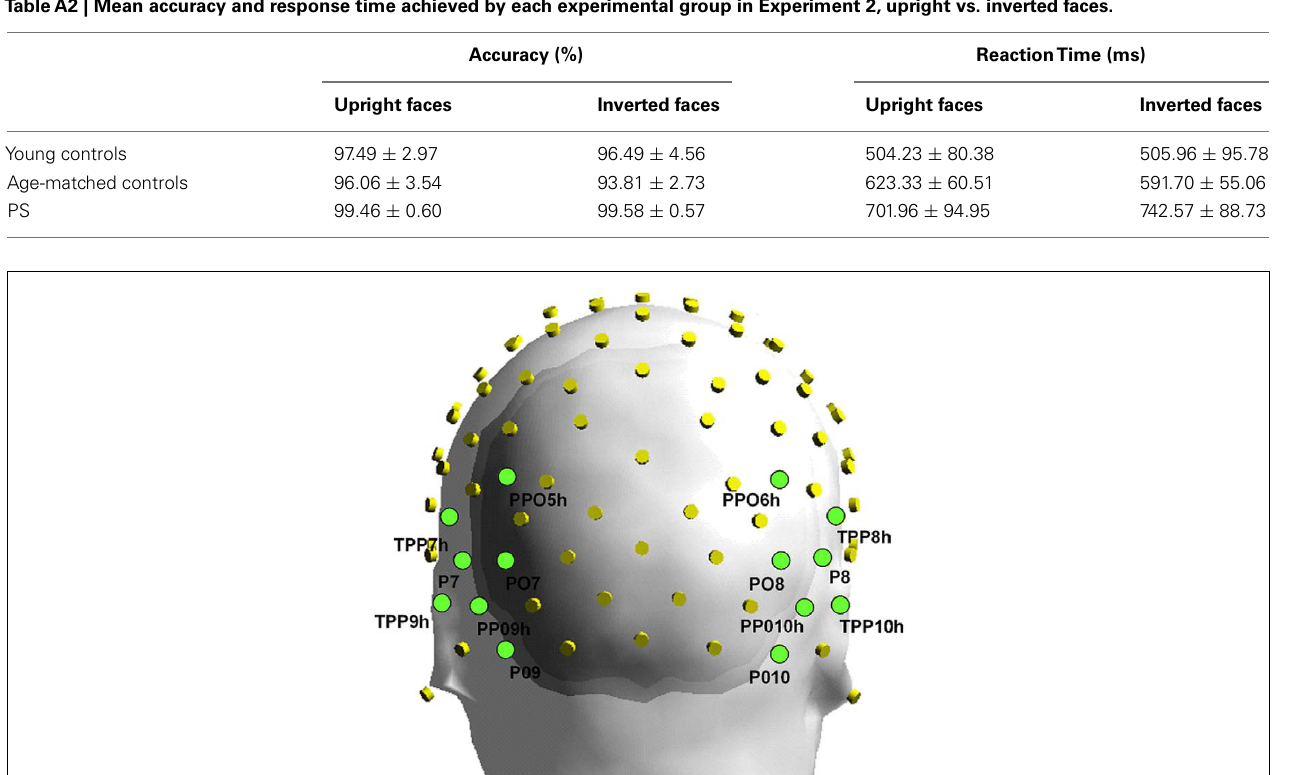
TableA2 | Mean accuracy and response time achieved by each experimental group in Experiment 2, upright vs. inverted faces.